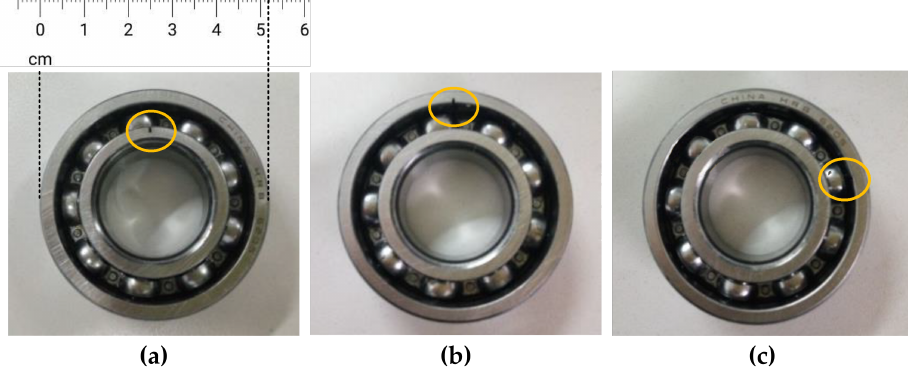
Figure 2. Typical examples of artificially generated bearing faults (i.e., dents and cracks using machining tools). In common scale: ( a ) outer race fault, ( b ) inner race fault, ( c ) ball